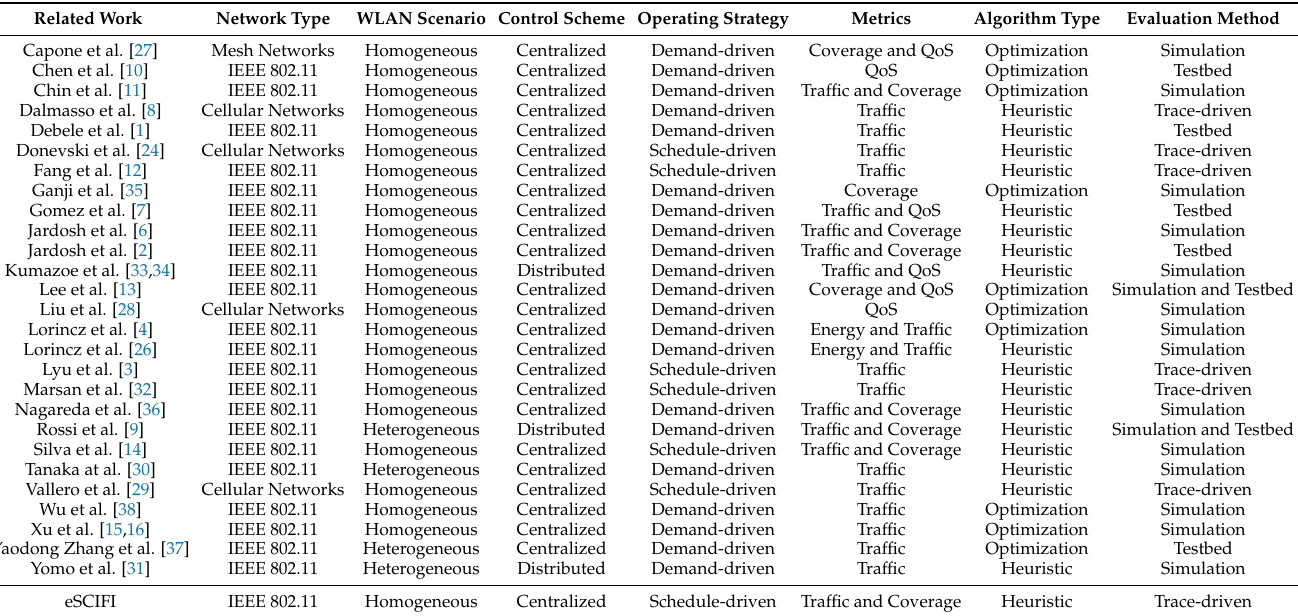
Table 1. RoD strategy mechanism related work comparison.